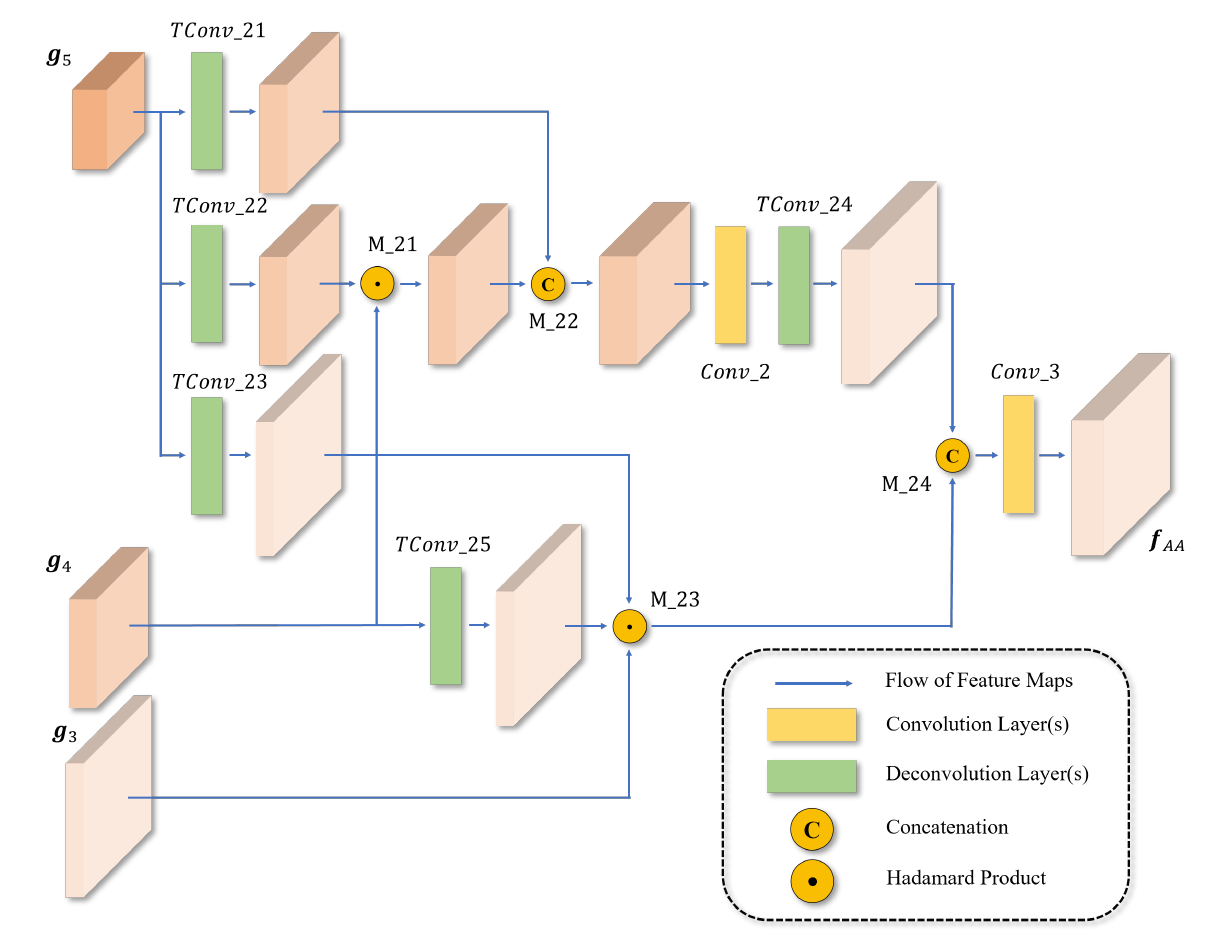
Figure 2. The detailed structure of the proposed pyramid partial decoder